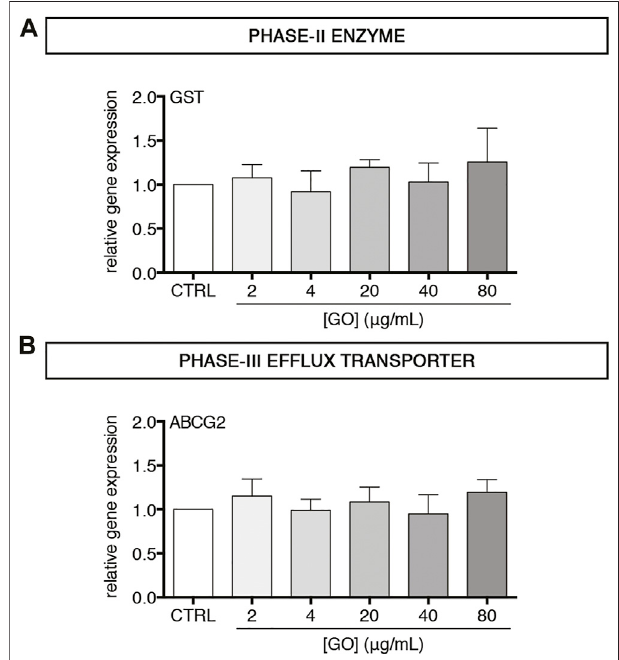
FIGURE 5 | Effect of sub-lethal GO doses on transcript levels of two representative executioners of phase – II and – III drug/xenobiotic metabolism in upcyte ® hepatocytes treated for 24 h (A – B) Relative gene expression of GST (A) and ABCG2 (B) in GO-treated cells versus untreated cells (indicated as CTRL). Results are expressed as means ± SD values of three independent